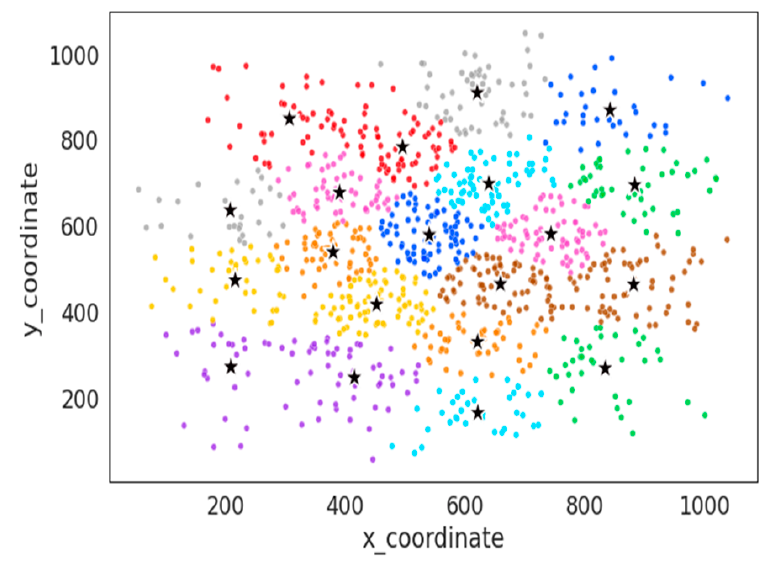
Figure 4. Representation of cluster head by black stars.